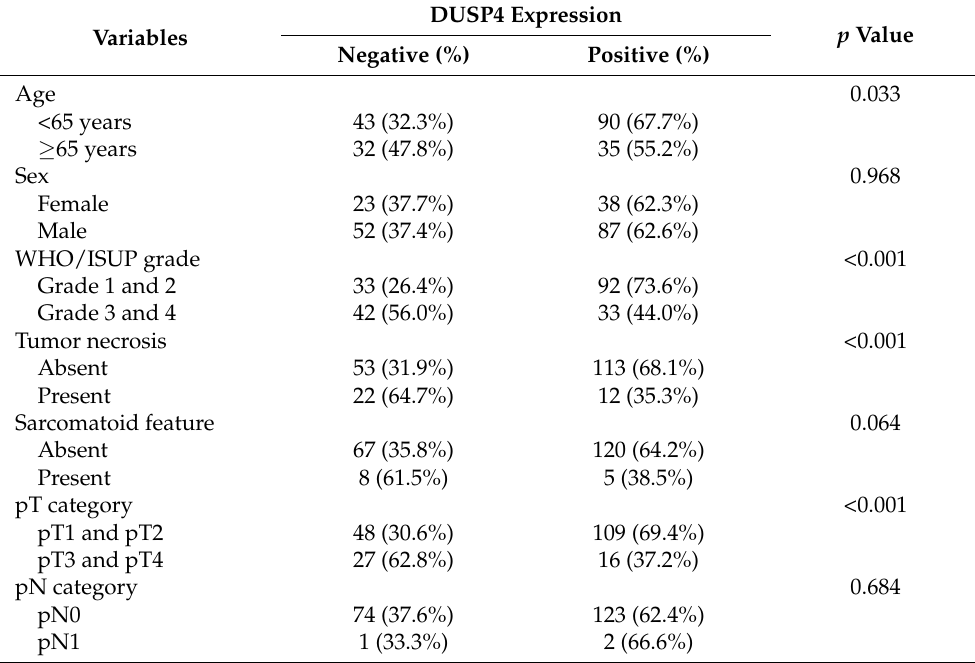
Table 3. Correlation between DUSP4 expression and clinicopathological characteristics in ccRCC.